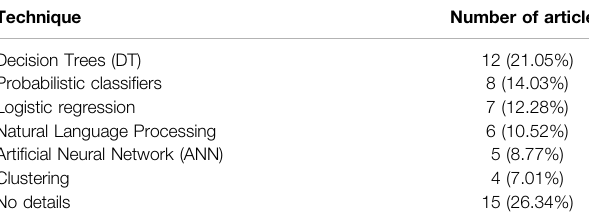
TABLE9| Mainmachinelearningtechniquesappliedtothecontextofhighschool .